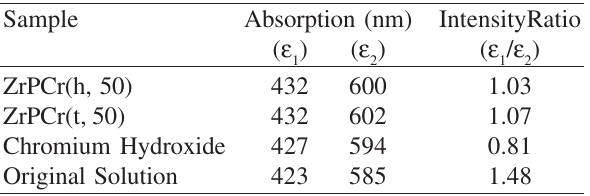
Table 3. Band features in electronic spectra of Cr(III) intercalated solids dried at 50 °C and reference samples.